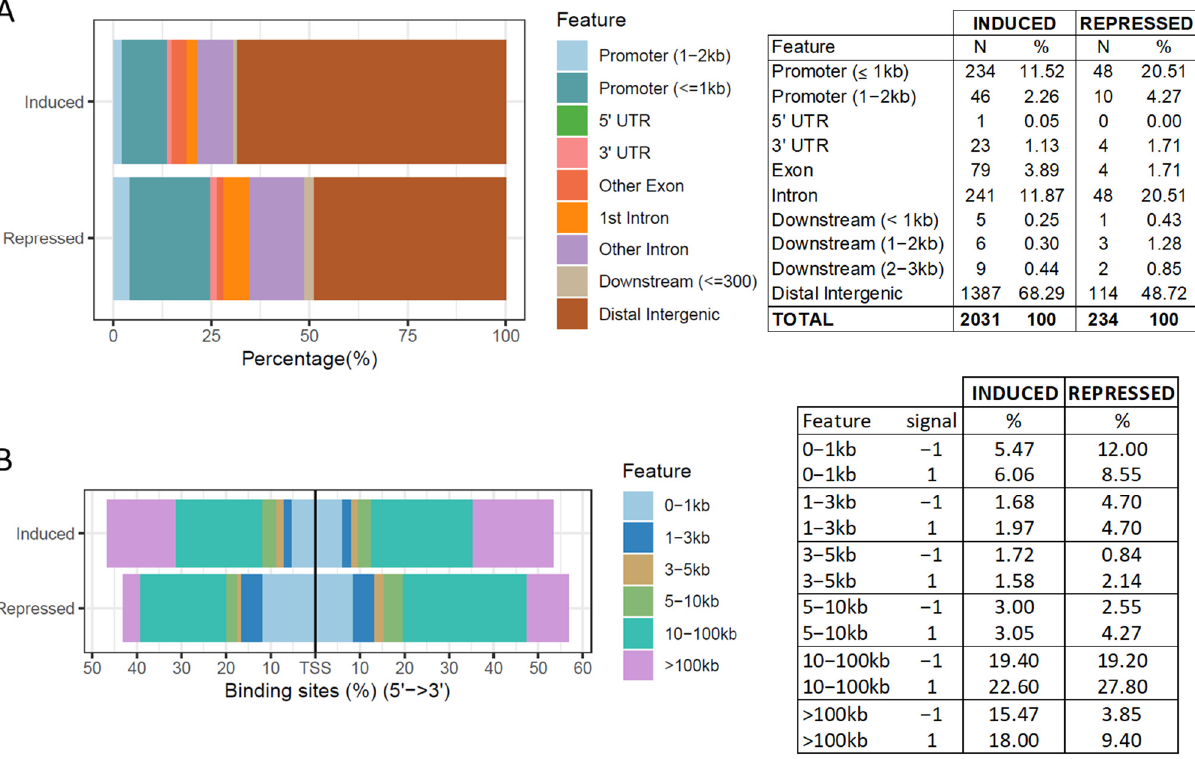
Figure 3. ( A ) Annotation of butyrate-induced and -repressed differentially CTCF-binding sites. ( B ) Distribution of the butyrate-induced and -repressed differentially CTCF binding sites relative to TSS.